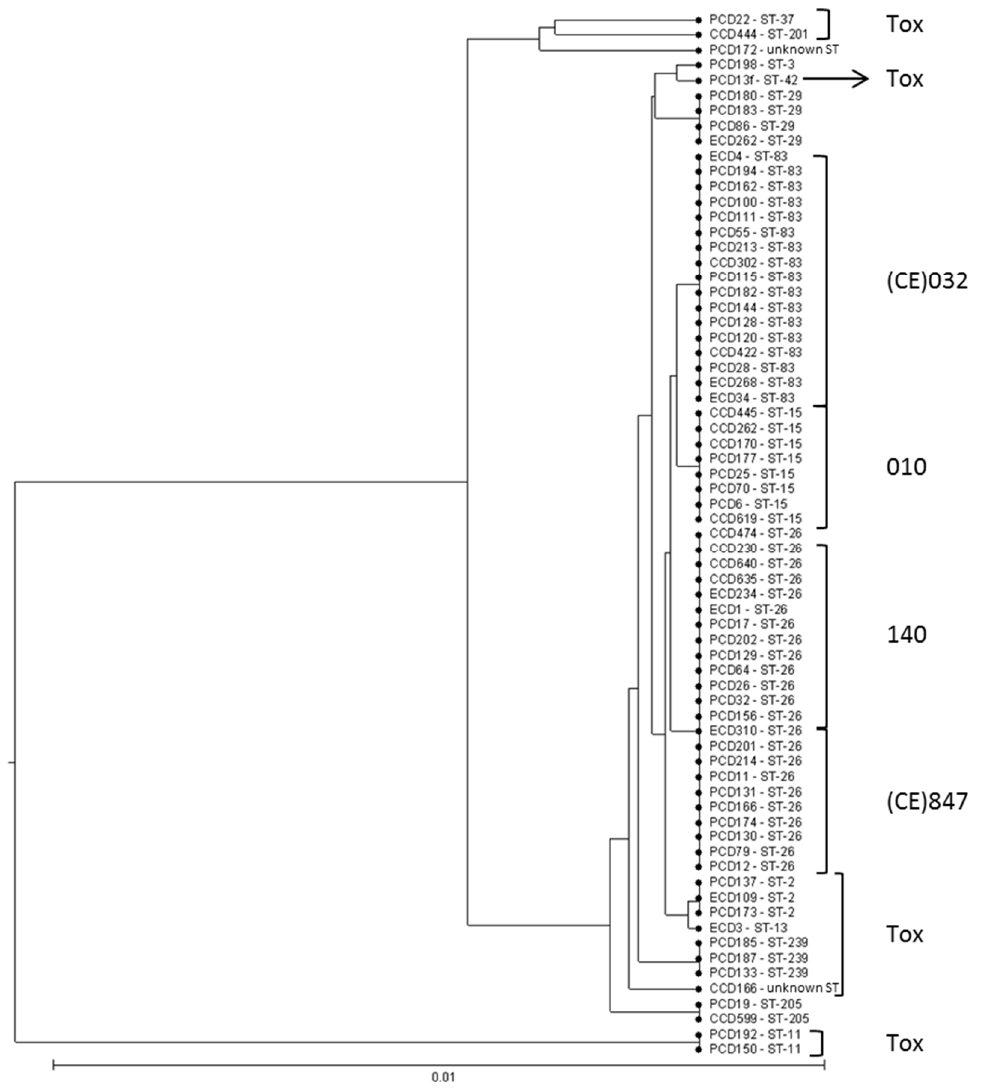
Figure 3. Tree representation of MLST data for 69 C. difficile strains with the UPGMA algorithm. The distance matrix was constructed using sequence profile data. Tox: toxigenic